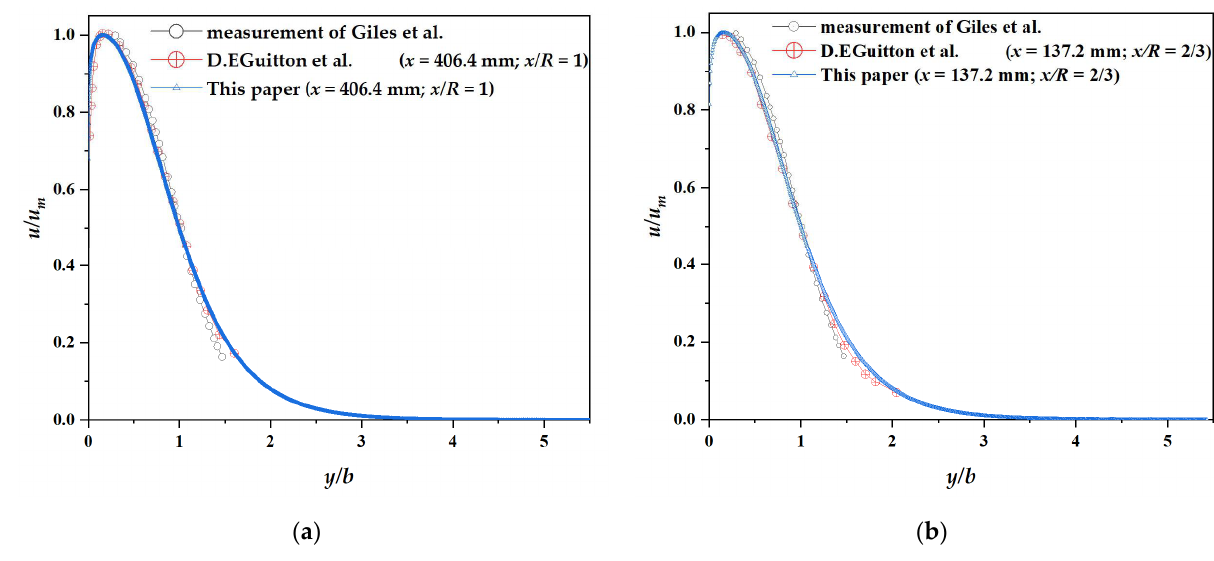
Figure 3. Mean velocity profiles. ( a ) x / R = 1; ( b ) x / R = 2/3.